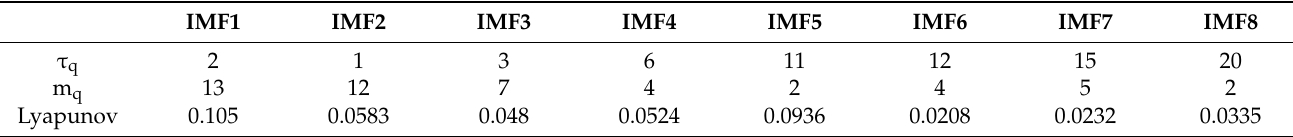
Table 1. Phase space reconstruction information